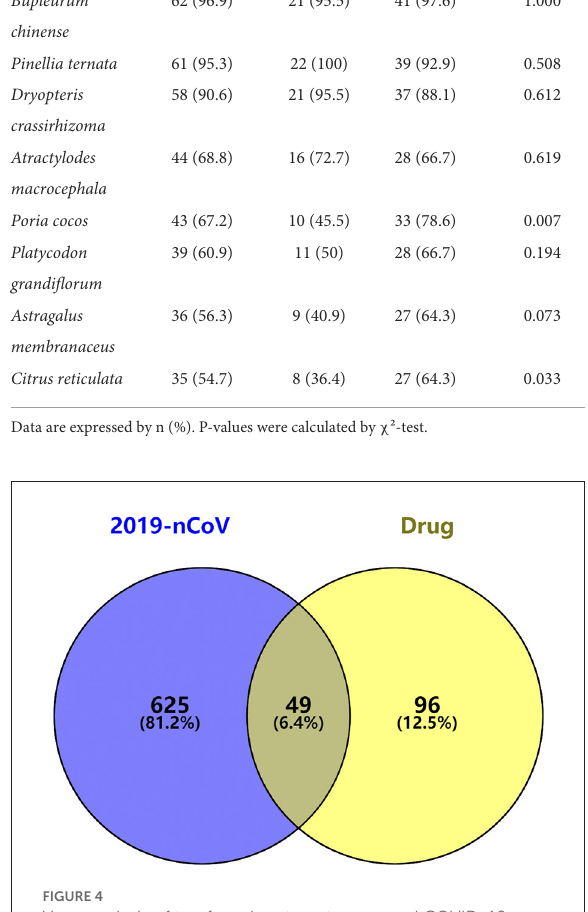
FIGURE4 Venn analysis of top four drug target genes and COVID-19 related genes.